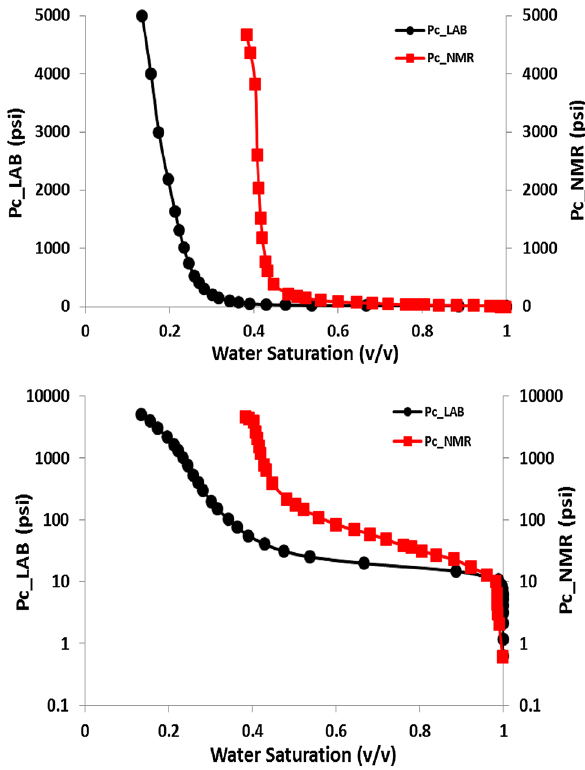
Fig. 18 Measured capillary pressure (black) and NMR capillary pres- sure (red) for the inter-channel thin bed unit indicating a poor match